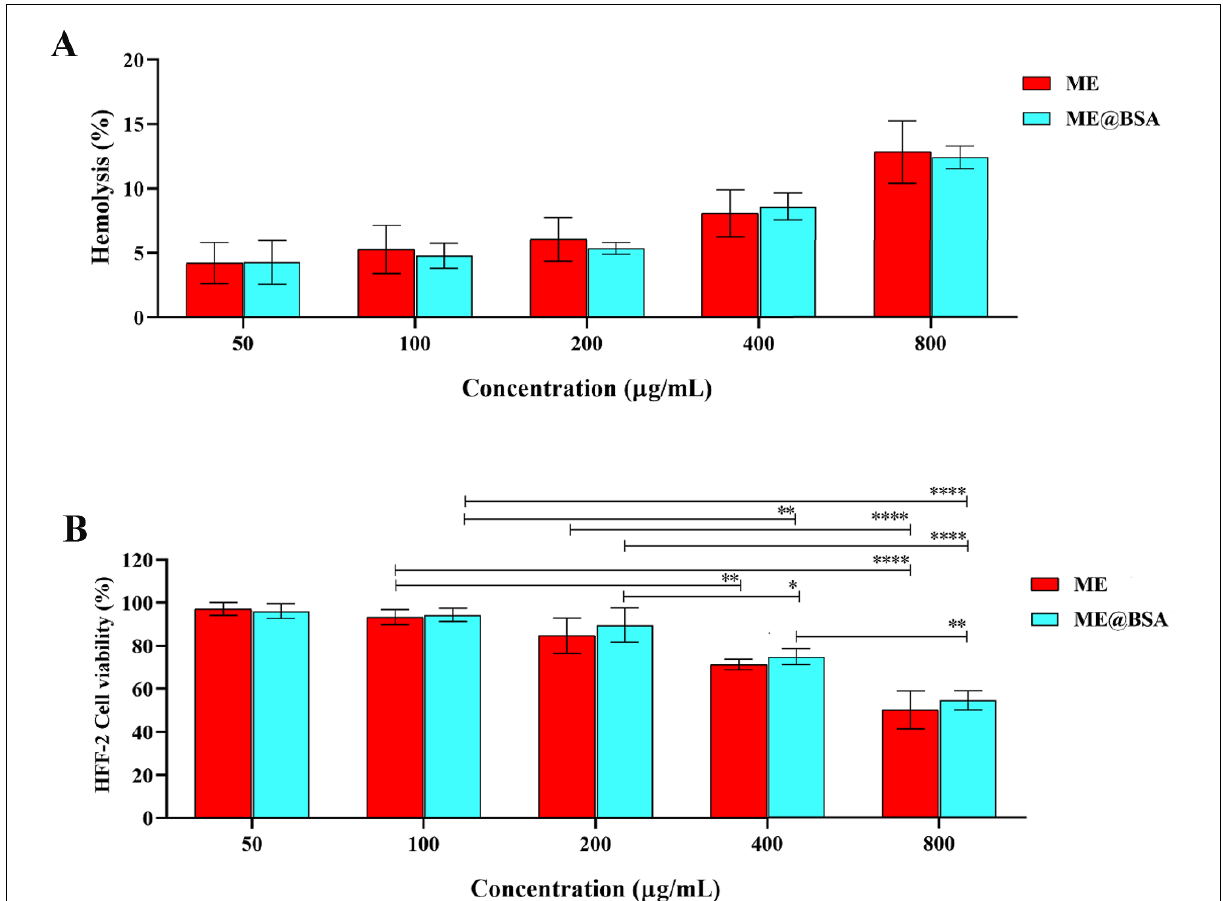
Figure 6. ( A ) Percentage of hemolysis induced by ME and ME@BSA at various concentrations and 37 °C temperature condition; ( B ) cell viabilities of the ME and ME@BSA on the HFF-2 cell lines. Data are represented as mean ± SD (n = 3) (* p < 0.05, ** p < 0.01, and **** p < 0.0001), and are considered as having significant , or no significant differences, respectively.